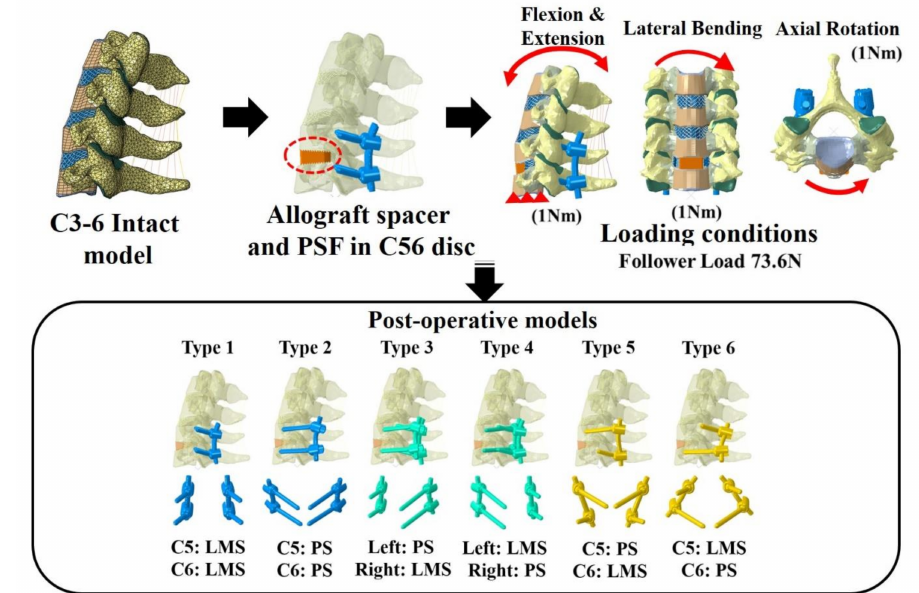
Figure 1. Finite element model and the six models with lateral mass screws (LMS) and pedicle screws (PS). Type 1: all LMS, Type 2: all PS, Type 3: left (Lt) PS and right (Rt) LMS, Type 4: Lt LMS and Rt PS, Type 5: upper PS and lower LMS, and Type 6: upper LMS and lower